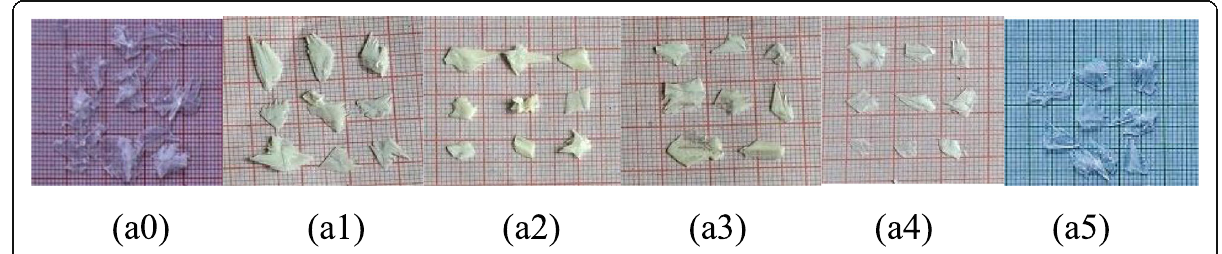
Fig. 3 Harvested CHPD (Brushite) crystals grown without inhibitor (Undoped (a0)), with A. marmelos (a1-a5)